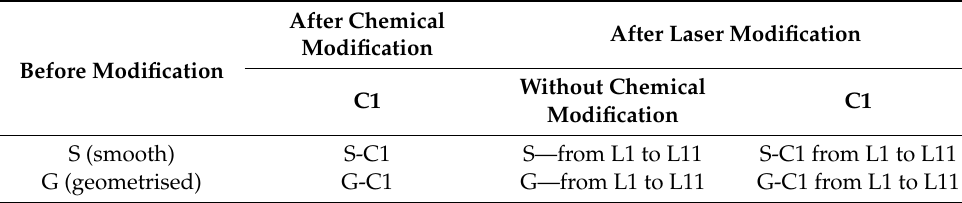
Table 3. Designation of samples.